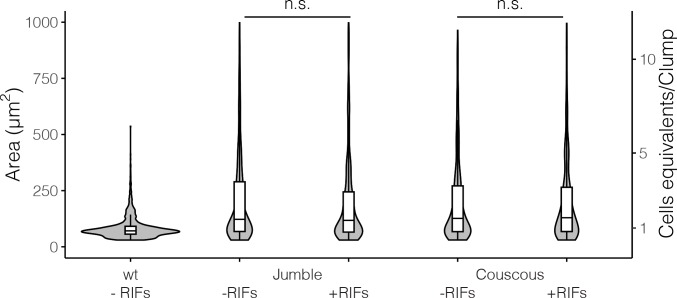
Jumble and Couscous clumps formed in the absence or presence of RIFs are comparable in size.Jumble and Couscous were cultured for 24 hr, either without RIFs or with RIFs. To perform the clumping assay, cells cultured either with or without RIFs were vortexed and then incubated for 30 min. Wild type cells without RIFs were included as a negative control. Clump sizes were quantified by automated image analysis. Data are presented as violin boxplots, showing the median cell number (horizontal line), interquartile range (white box), and range excluding outliers (vertical line). There were no significant differences in clump size in mutants treated with RIFs or without RIFs (K-S test, n.s. = not significant, p > 0.05).